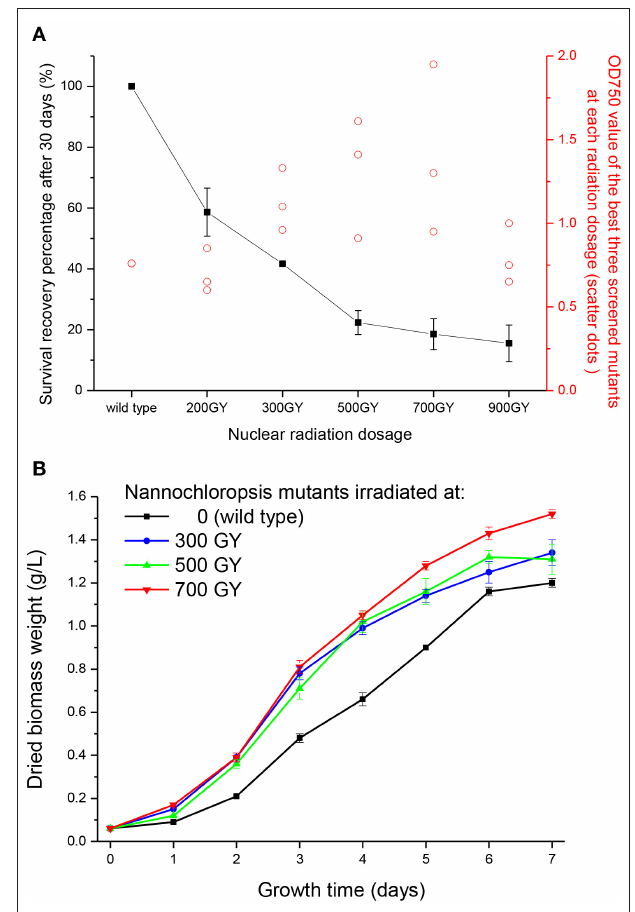
FIGURE 1 | Survival recovery percentage and growth curves of Nannochloropsis mutants after various nuclear radiation dosages. (A) Survival recovery percentage on the 30th day after nuclear radiation and OD 750 value of the best three screened mutants at each radiation dosage (scatter dots). (B) Growth curves of screened Nannochloropsis